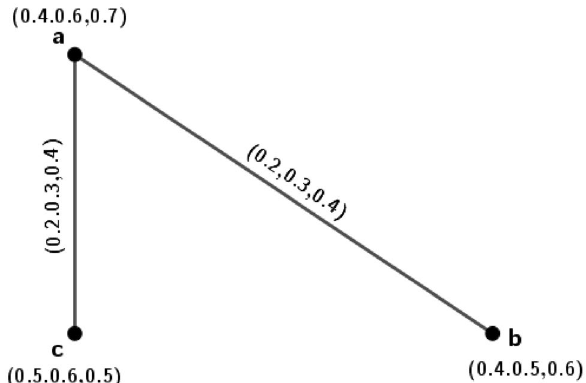
Figure 10. Antipodal 3PFG A (Γ ) .